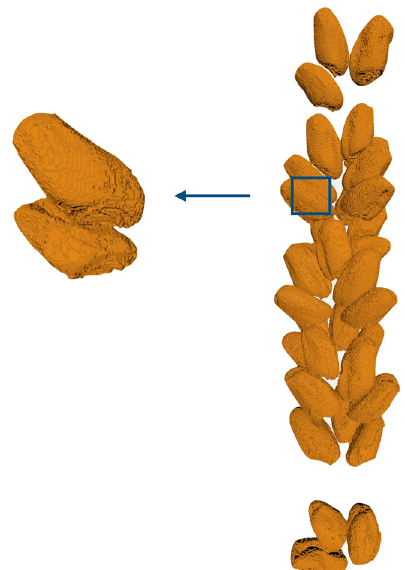
Figure 20. The proposed method failed to find one grain in treatment No. 1180 spike because the grain is very close to another